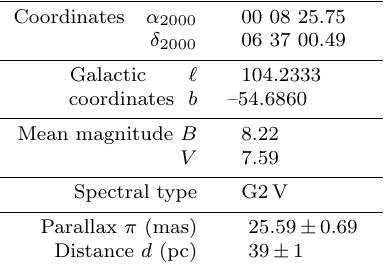
Table 1. Basic parameters of HD 377 (SIMBAD